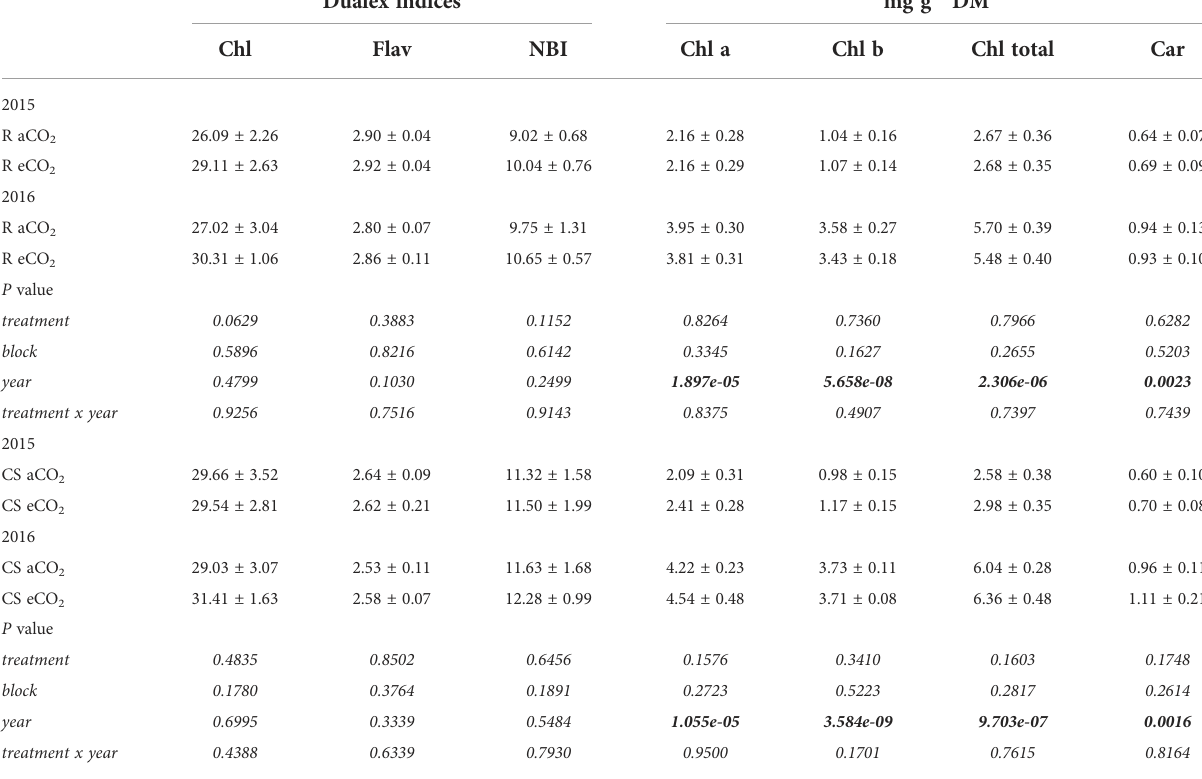
TABLE 2 Results of optical leaf clip meter readings of leaf chlorophyll (Chl), fl avonols (Flav) and nitrogen balance index (NBI) as well as leaf pigment content (in dry matter, DM) for chlorophyll a (Chl a), chlorophyll b (Chl b), total chlorophyll (Chl total) and carotenoid (Car) of the two cultivars Riesling (R) and Cabernet Sauvignon (CS) under aCO 2 and eCO 2